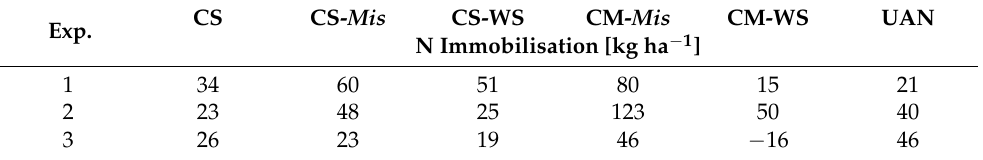
Table 9. N immobilisation calculated of MBN of fertilised treatments and non-fertilised treatment (CS = Cattle Slurry, CS- Mis = Cattle Slurry- Miscanthus (5 kg to 1 kg), CS-WS = Cattle Slurry-Wheat Straw (8.5 kg to 1 kg), CM- Mis = Cattle Manure from Miscanthus shredded bedding, CM-WS = Cattle Manure from Wheat Straw shredded bedding, UAN = Urea Ammonium Nitrate). CS CS- Mis Exp.